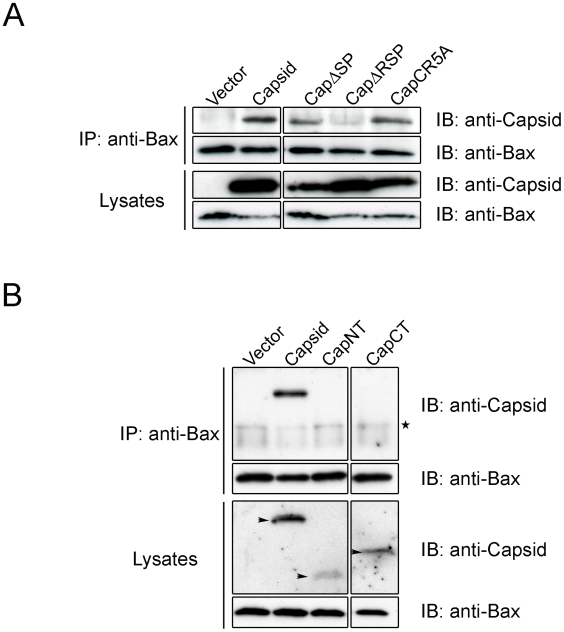
The carboxyl-terminal R motif in capsid protein is required for binding to Bax.A549 cells transiently expressing capsid, CapNT, CapCT, CapΔSP, CapΔRSP, CapC5RA or vector alone were subjected to immunoprecipitation (IP) with rabbit anti-Bax under non-denaturing conditions. Samples were resolved by 10% (A) or 15% (B) SDS-PAGE and analyzed by immunoblotting (IB) with goat anti-RV to detect capsid proteins or mouse anti-Bax. Arrowheads in the lower panel denote the various capsid constructs. The asterisk indicates IgG light chain.